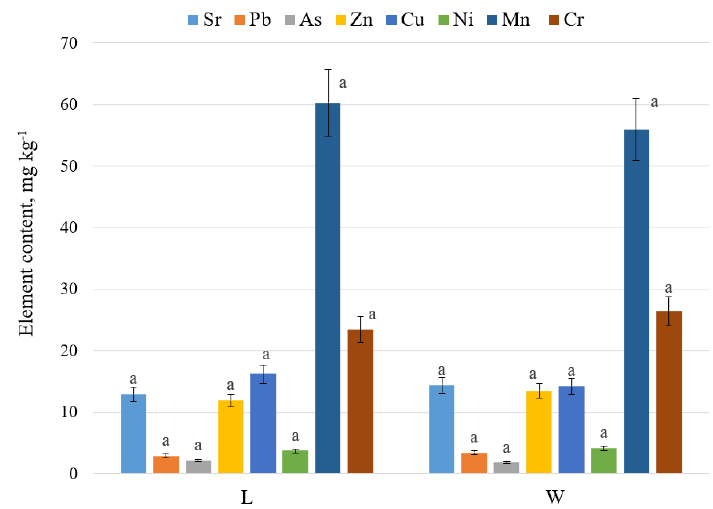
Figure 1. Element content in the accumulative soil horizon (0–10 cm) on the windward (W) and leeward sides (L) of the foredune, mg kg − 1 dry weight (DW), July 2018. Data are expressed as mean values ± standard deviations, (n = 45). Letters indicate statistical difference; means with the same letter are not statistically different (Student’s t- test, p < 0.05).